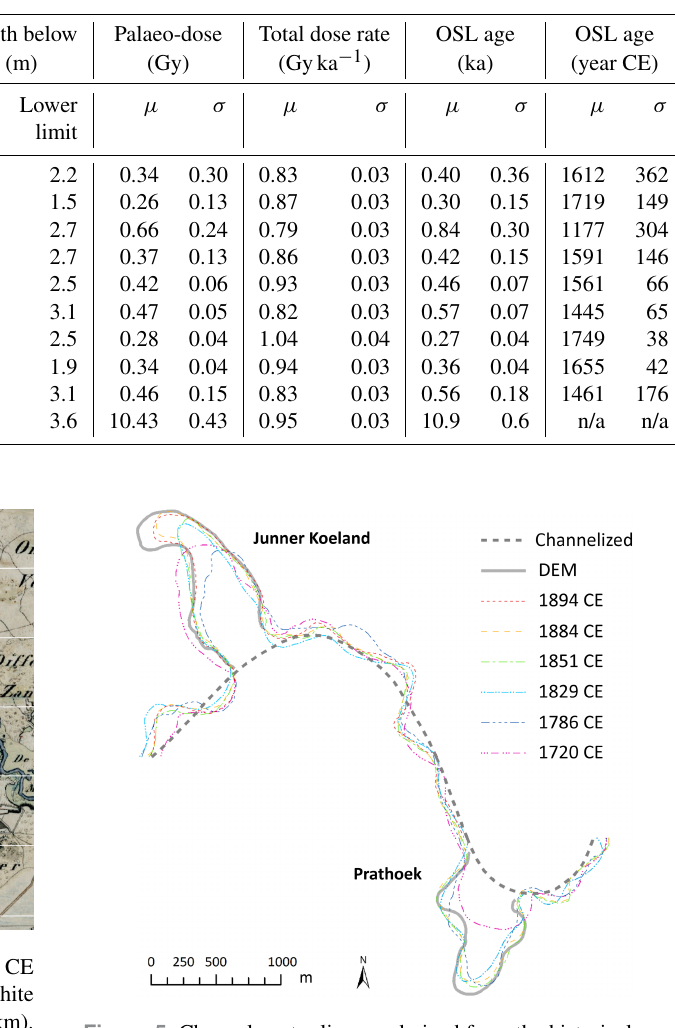
Figure 5. Channel centre lines as derived from the historical maps listed in Table 1 and shown in Fig. 2. The DEM (digital eleva- tion model) line represents the course of the meanders preserved upon abandonment at the time of channelization (between 1884 and 1901 CE for Prathoek and between 1894 and 1906 CE for Junner